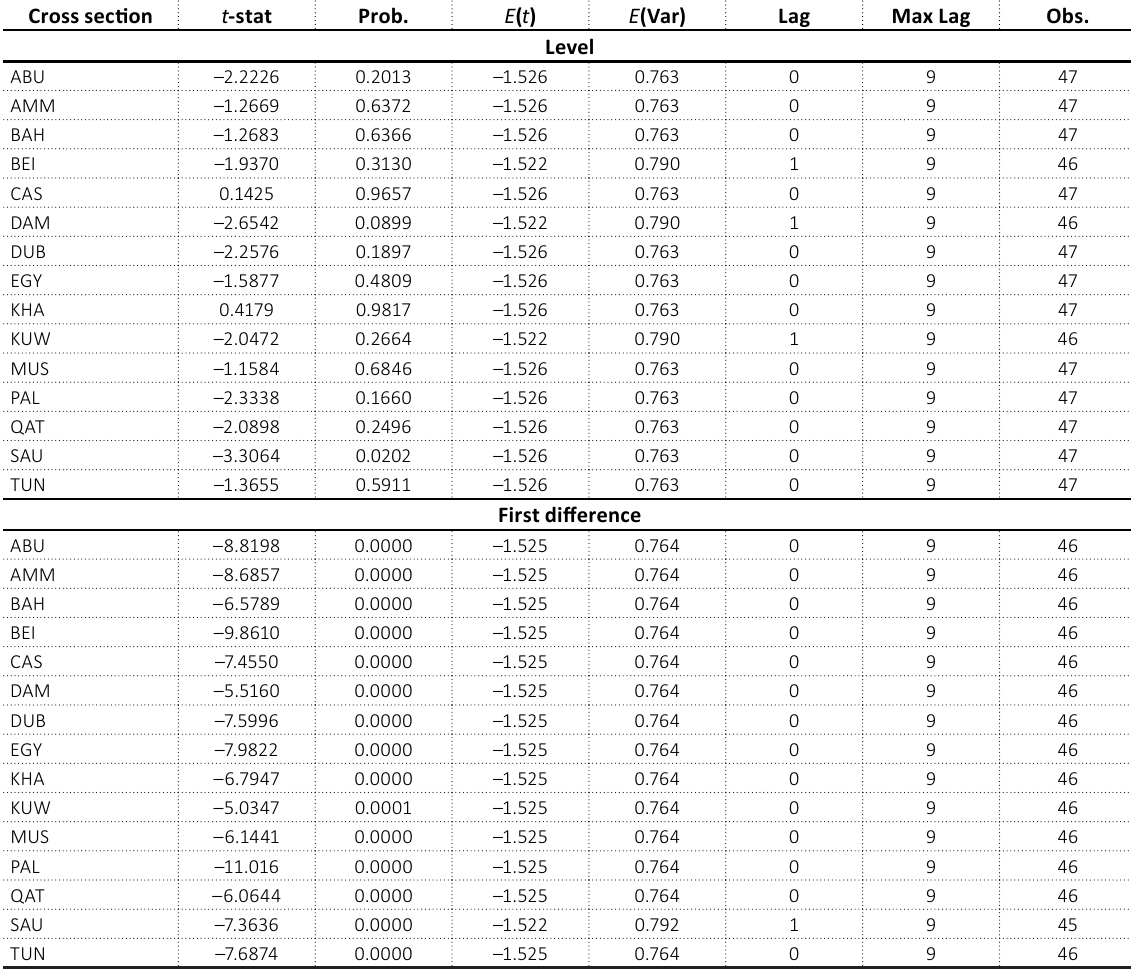
Table 3. Results: intermediate ADF unit root Cross